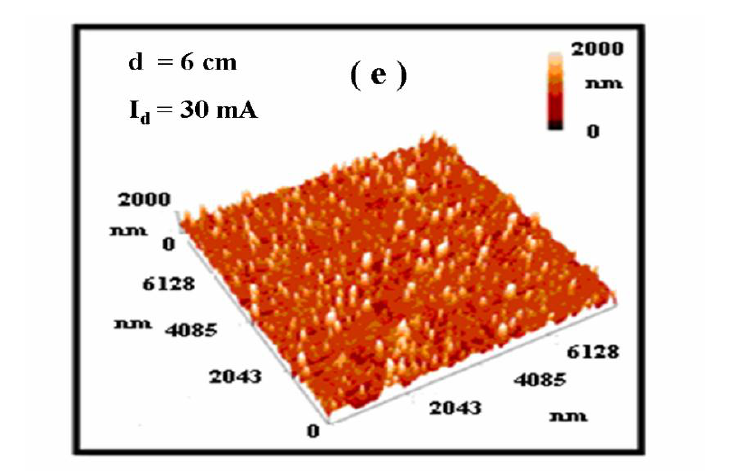
Fig.8: 3D images from AFM results for depositing gold on glass substrate P=0.2 mbar and t = 30 sec for different electrode